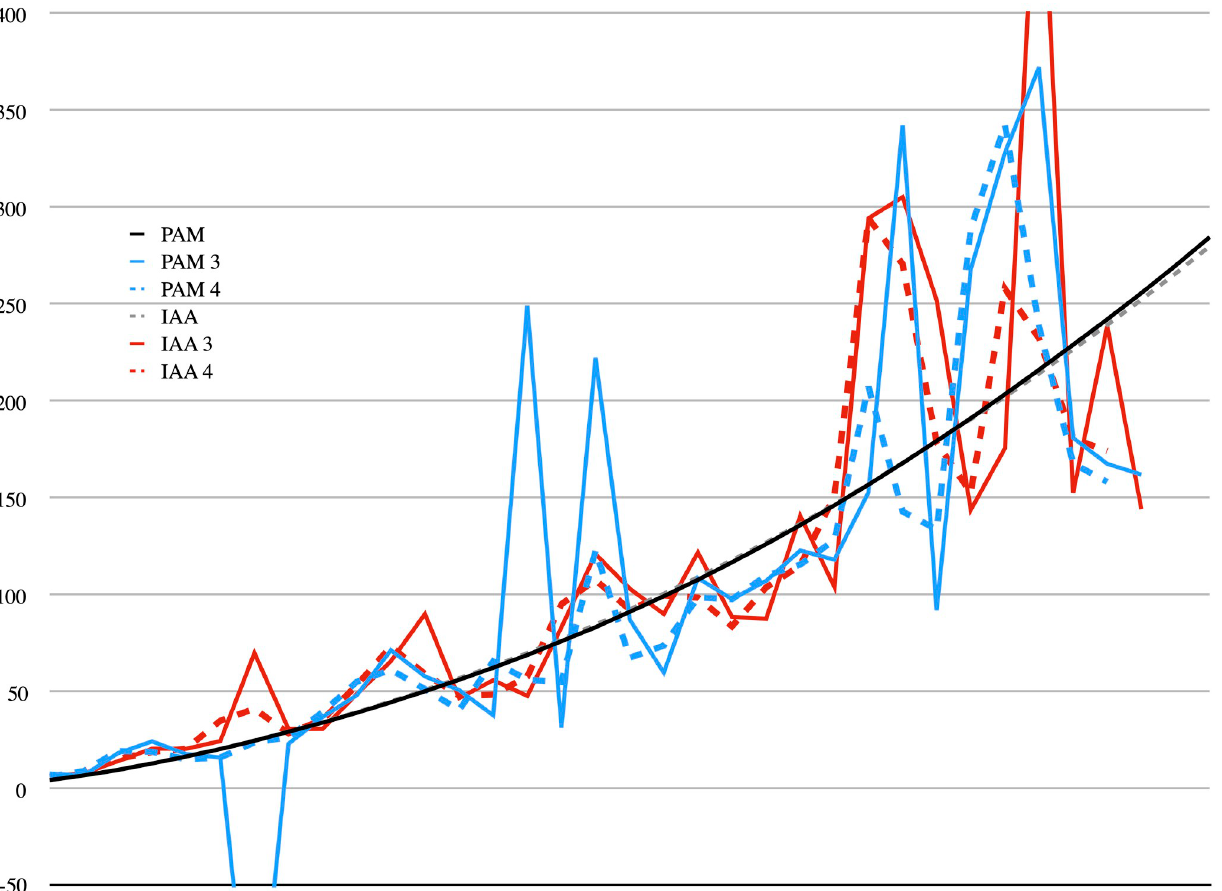
Fig 7. 11Q5 ( The Great Psalms Scroll ). Measured length compared to calculated lengths in cms. The smooth (black) curves are the actual lengths as measured on the PAM (solid) and IAA/Shrine (dashed) images. Calculated estimates are shown for both PAM (blue) and IAA/Shrine (red) fragments, for three damage points (solid) and four (dashed). Some outliers are “off the chart.” A negative length indicates that the method fails to infer the correct direction of